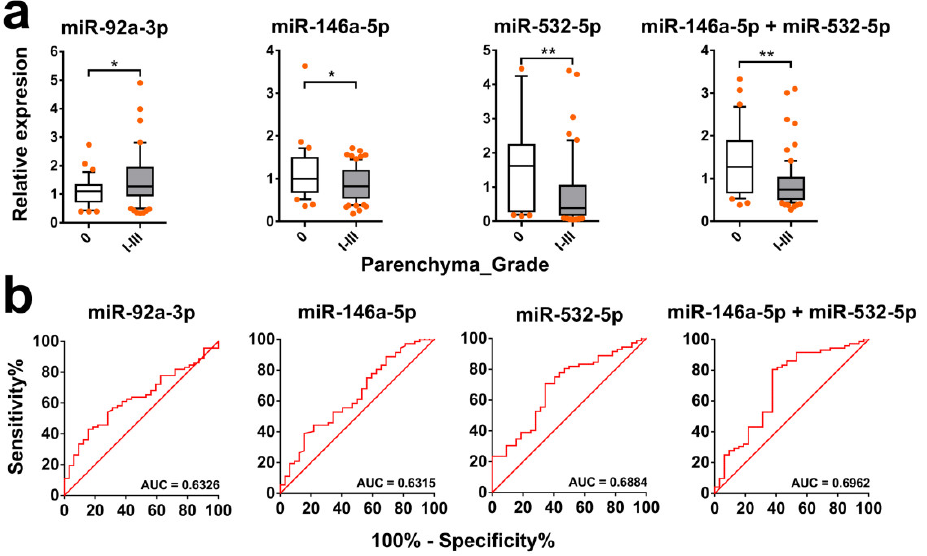
Figure 7. Discrimination of schistosomiasis hepatic fibrosis grades I–III vs. 0 by levels of exomiRs in